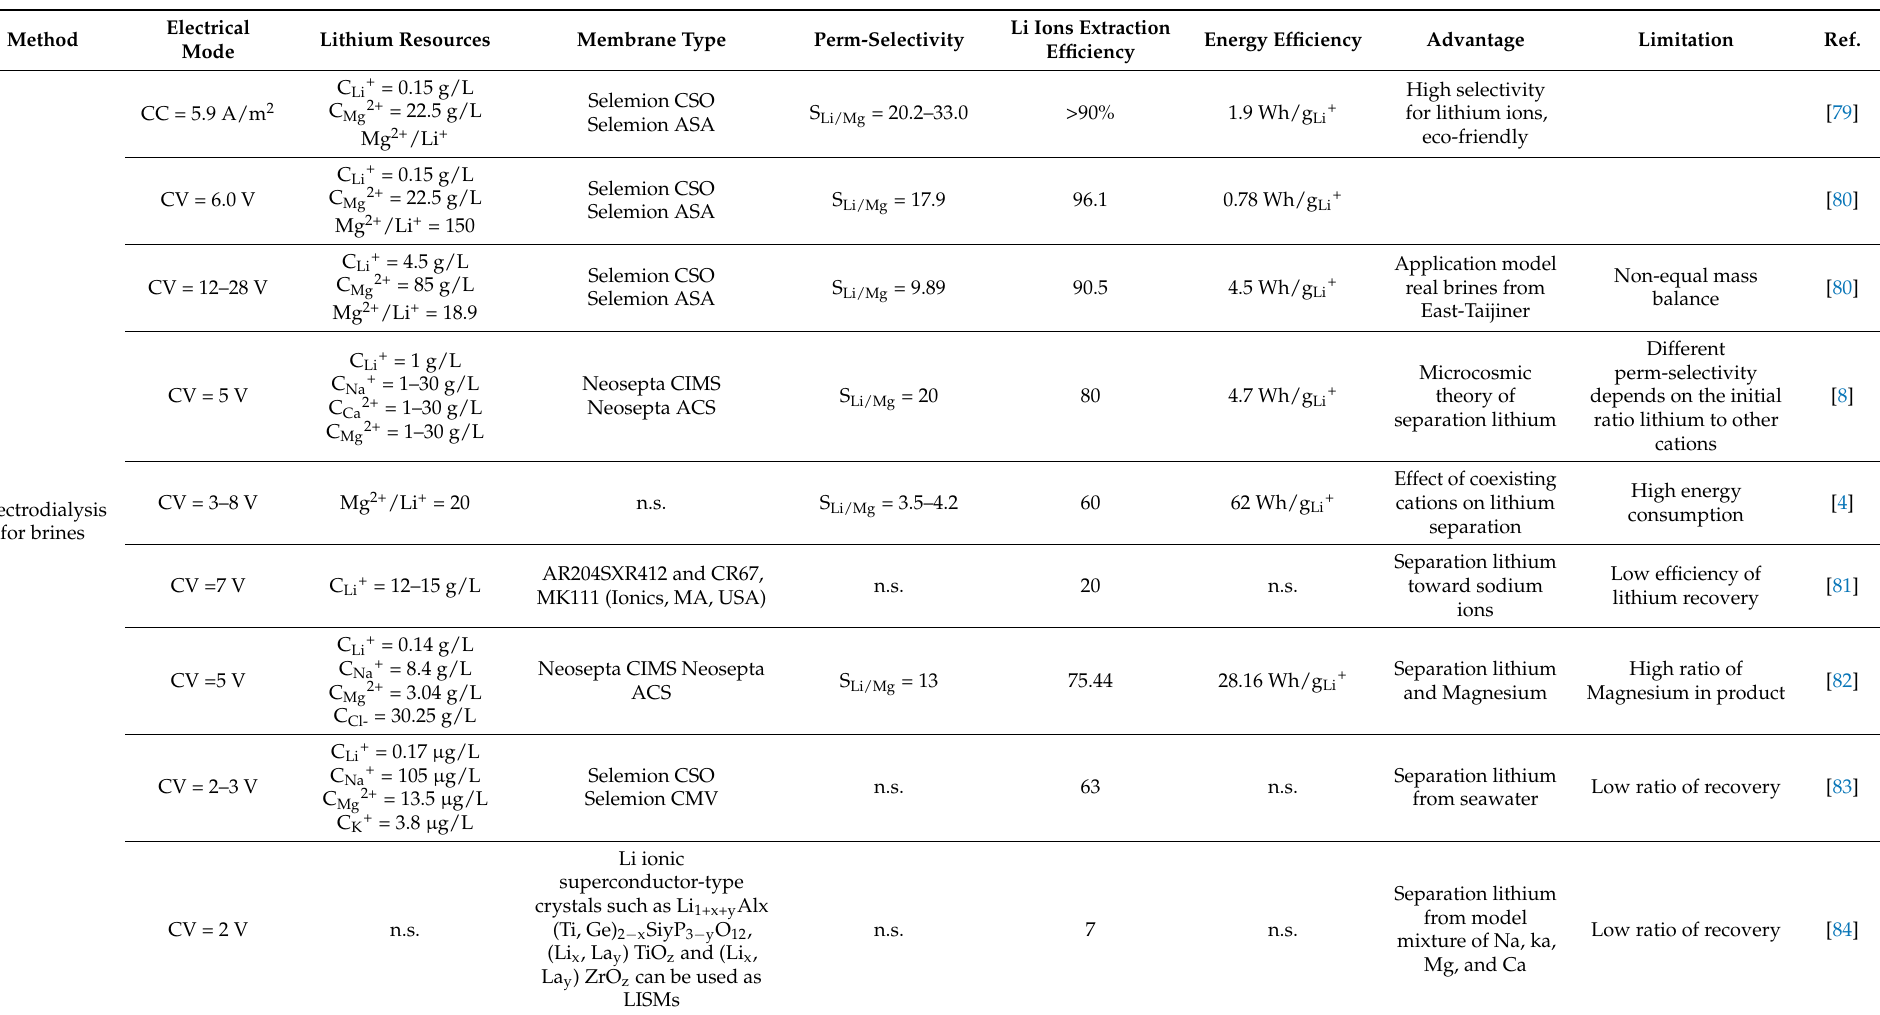
Table 7. Electrodialysis process for lithium separation from aqueous